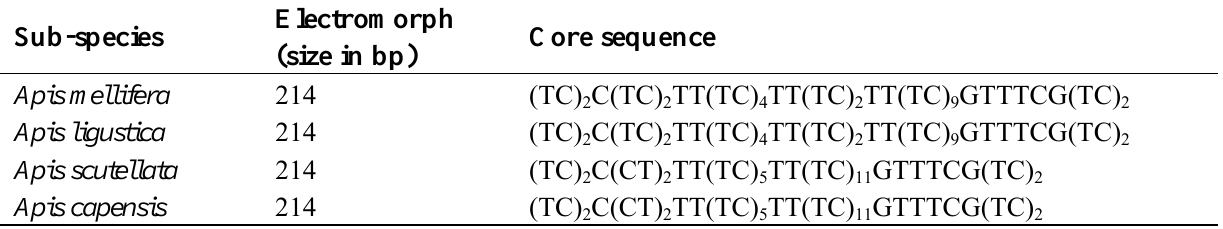
Table 2. SSR size homoplasy at the locus A113 in different subspecies of Apis mellifera